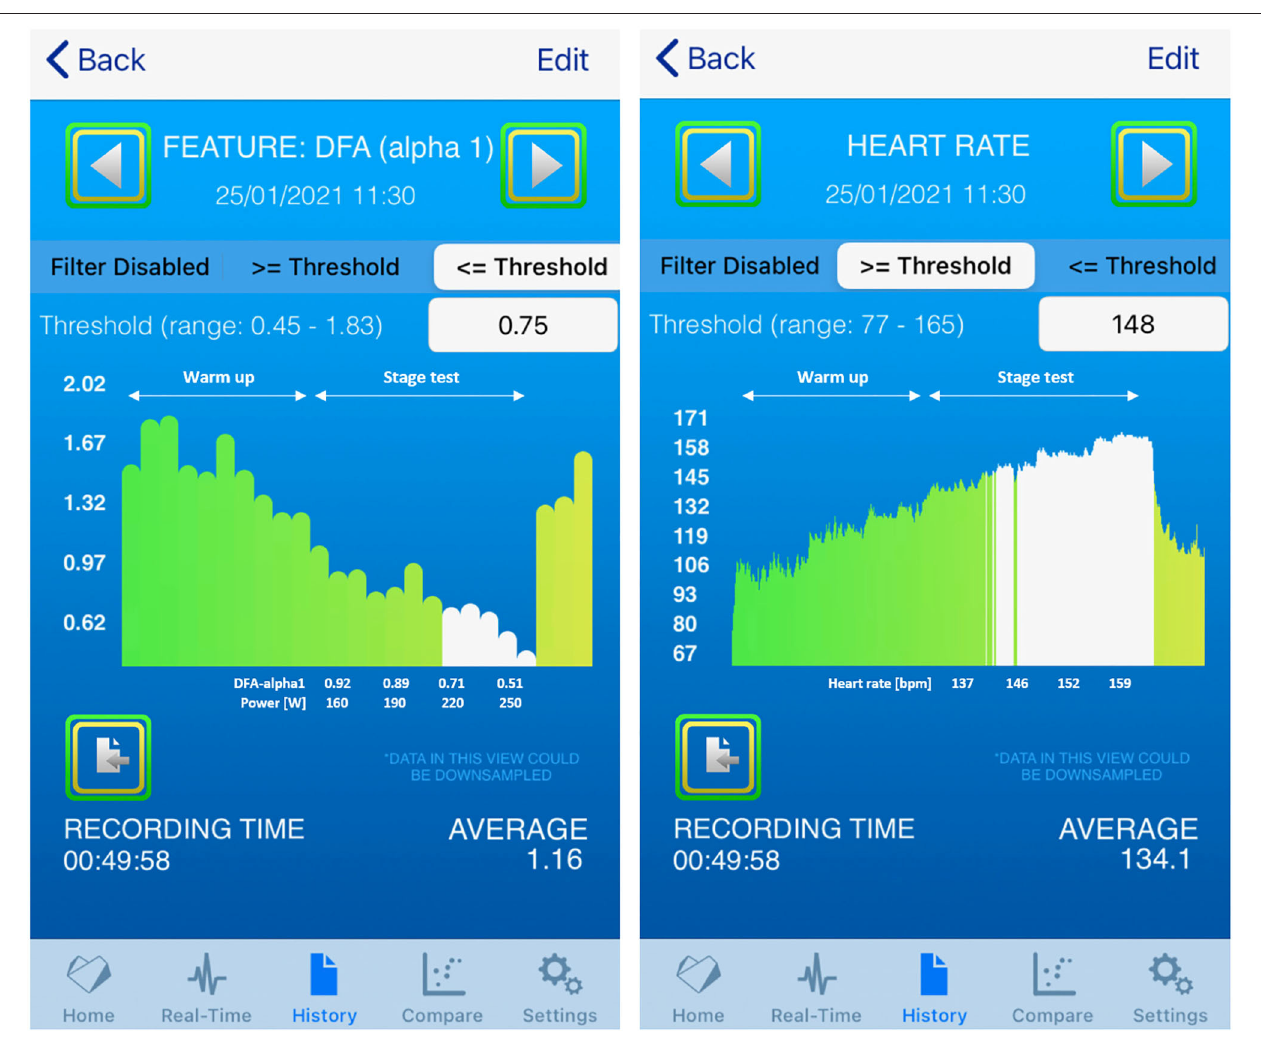
FIGURE 2 | History view of the incremental 6min stage test from 160 to 250W and included values (left: DFA-alpha1 with power values, right: HR); DFA-alpha1 values displayed in white are the average of the two data points taken at 4 and 6min.